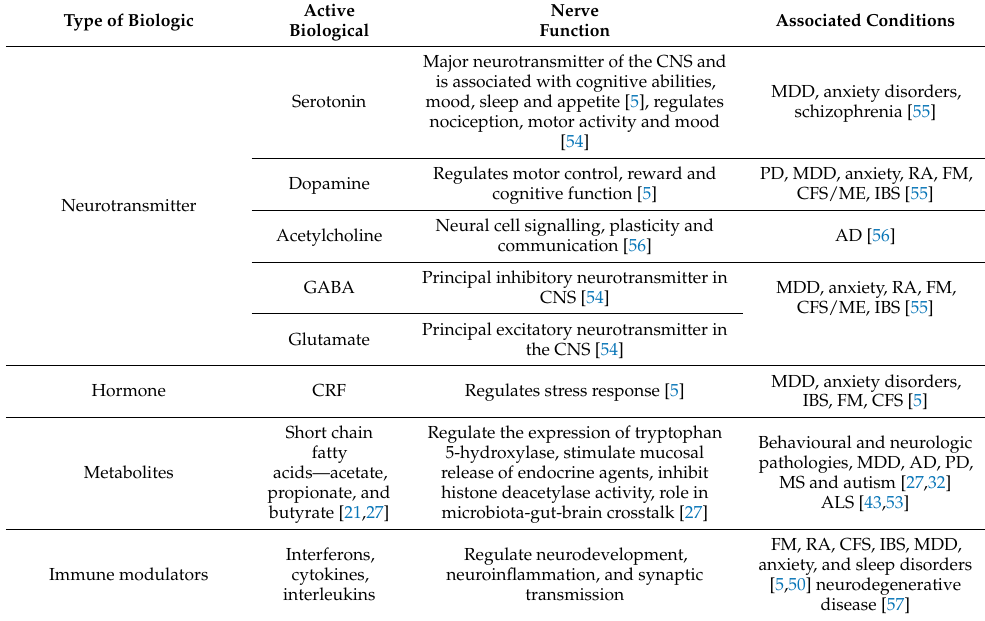
Table 3. Biologically active compounds produced by or stimulated by resident gut microbiota, their nerve function and associated conditions of chronic